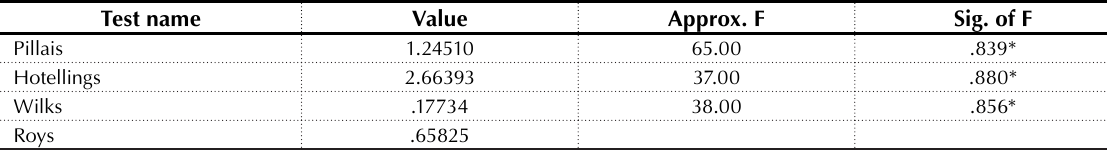
Table 18. Multivariate tests of